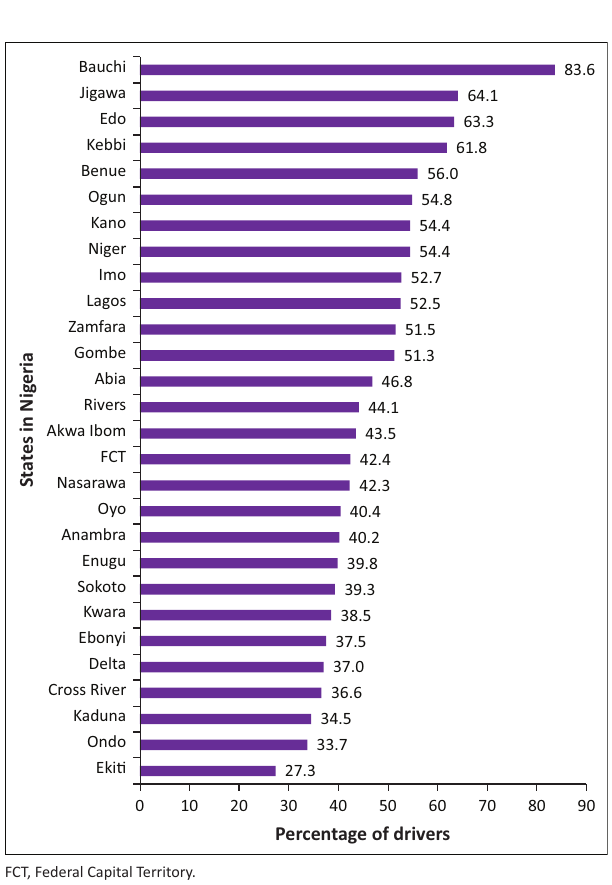
FIG URE 2: Percentage of drivers with a licence who had undergone an eye test before issuance of the